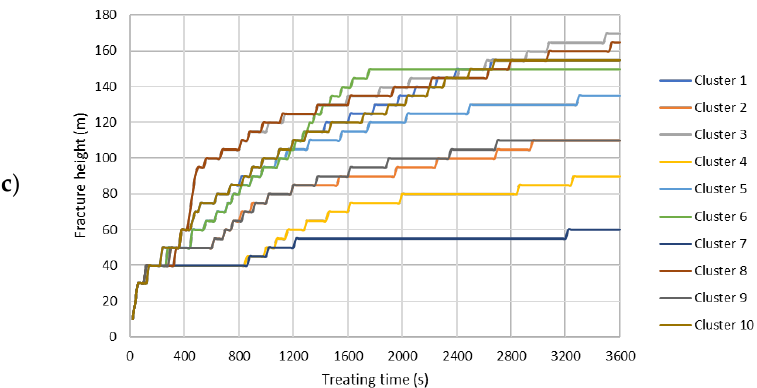
Figure A3. Fracture height of each cluster during the hydraulic fracturing treatment. ( a ) Slick water case. ( b ) NG foam case. ( c ) Hybrid NG/NG foam case.